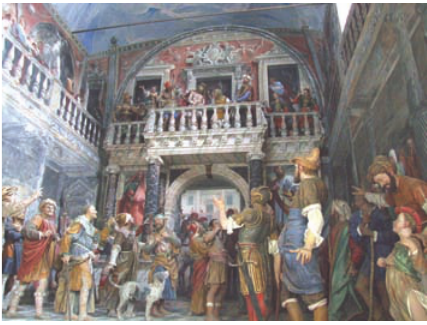
Figure 3: Chapel XXXIII. Ecce Homo .